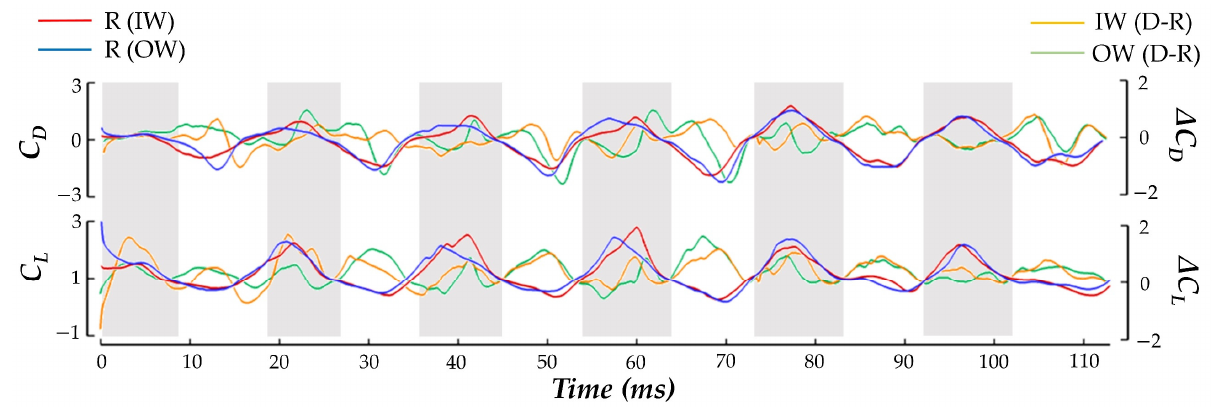
Figure 13. Drag and lift coefficient production comparison for the R model, with red indicating IW and blue indicating OW. The left-hand side y-axis represents the R model force coefficients, while the right-hand side y-axis represents the difference between the D and R